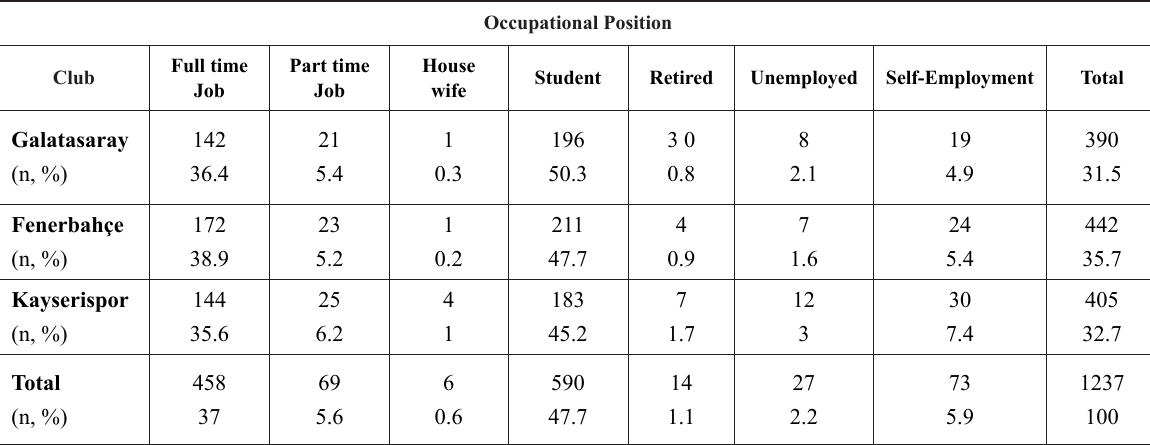
Table 4. Distribution according to occupational status of